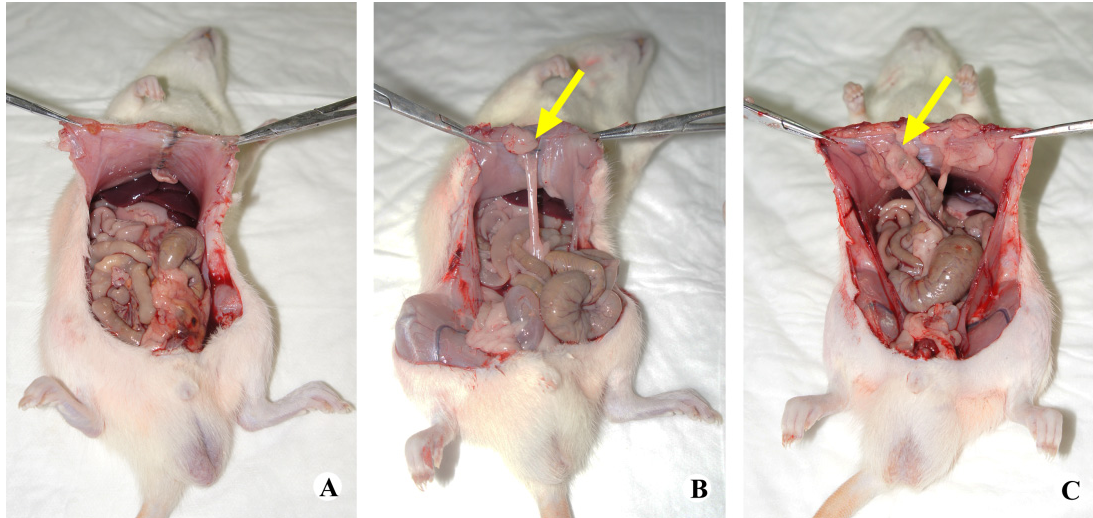
of fibrous tissue formation in the group wrapped with single-layer membrane and re-epithelialized abdominal wall defect site is unclear. Views of the abdominal wall and cecum surface in untreated group displayed a strong, fibrous tissue layer formed between the cecum and abdominal wall surfaces. Figure 2. Gross evaluation of a rat cecum abrasion model after 14 days. ( A ) Group treated with bi-layer membrane; ( B ) Group treated with single-layer membrane; ( C ) Untreated group. Yellow arrows indicate the adhesion areas.